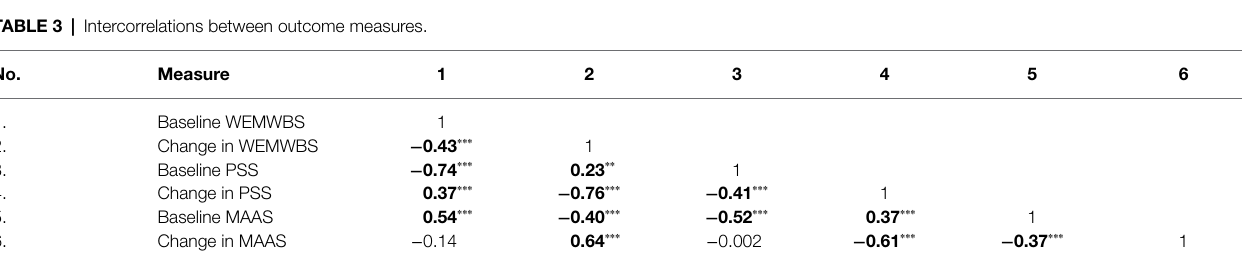
TABLE 3 | Intercorrelations between outcome